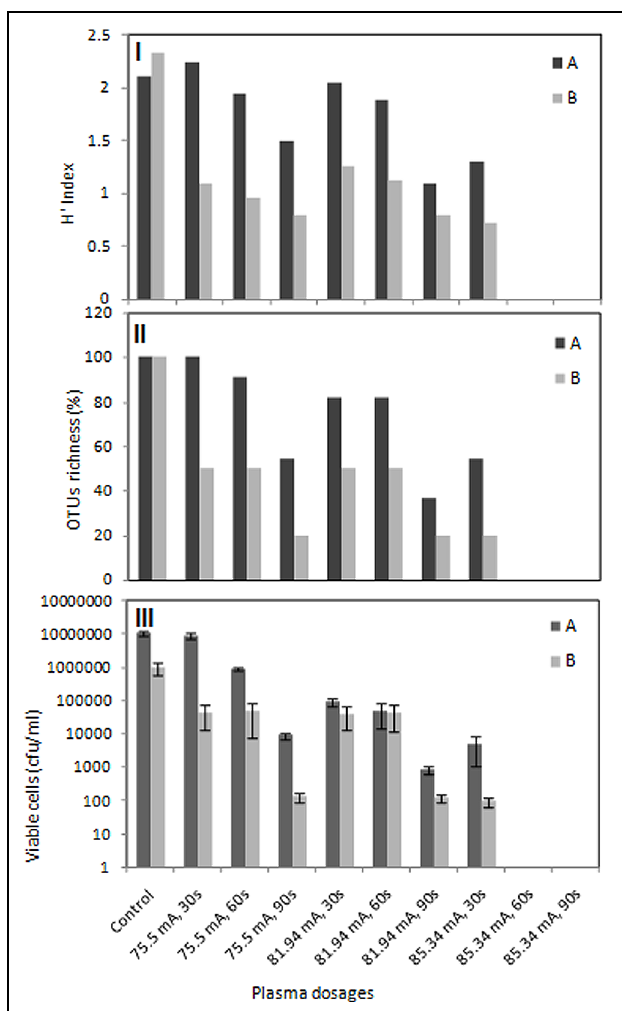
FIGURE 6 | Effects of DBD plasma on diversity, OTUs richness and cell viability. Numerical analysis of the DGGE fingerprints to determine diversity represented by H index (I) and OTUs richness (II) as well as viable cell counts (III) of bacterial populations in food processing (A) and leather processing (B) wastewaters. Viable cell counts are represented as means of three independent enumerations ( ±